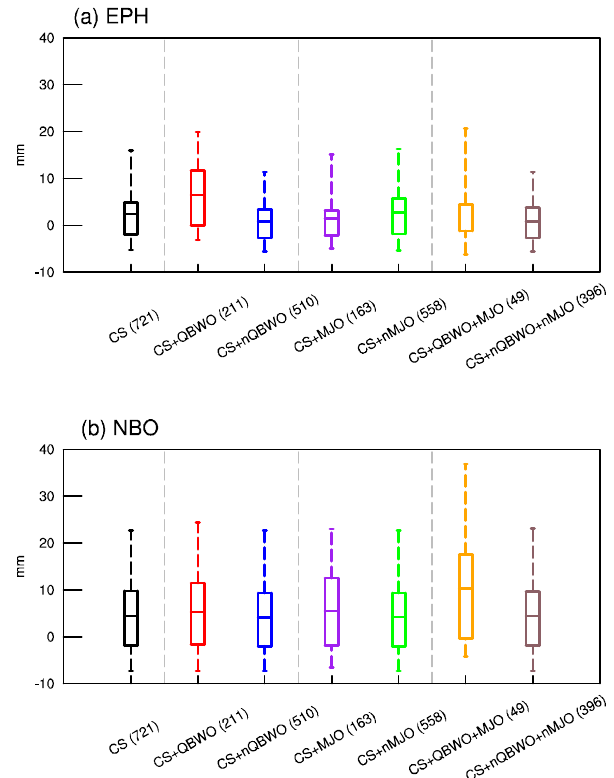
Figure 11. Box plots with the 5–95% and 25–75% ranges of rainfall (unit: mm) area−averaged over the EPH (( a ) 10 ◦ –20 ◦ N, 120 ◦ –135 ◦ E) and NBO (( b ) 5 ◦ –12.5 ◦ N, 110 ◦ –120 ◦ E) during the days of all cold surges (black), when cold surges co-existed with the QBWO (red), when cold surges occurred without the QBWO (blue), when cold surges co-existed with the MJO (purple), when cold surges occurred without the MJO (green), when cold surges co-existed with both ISO modes (orange), and when cold surges occurred without any ISO modes (brown), respectively. Number in x-axis indicates the composite days.